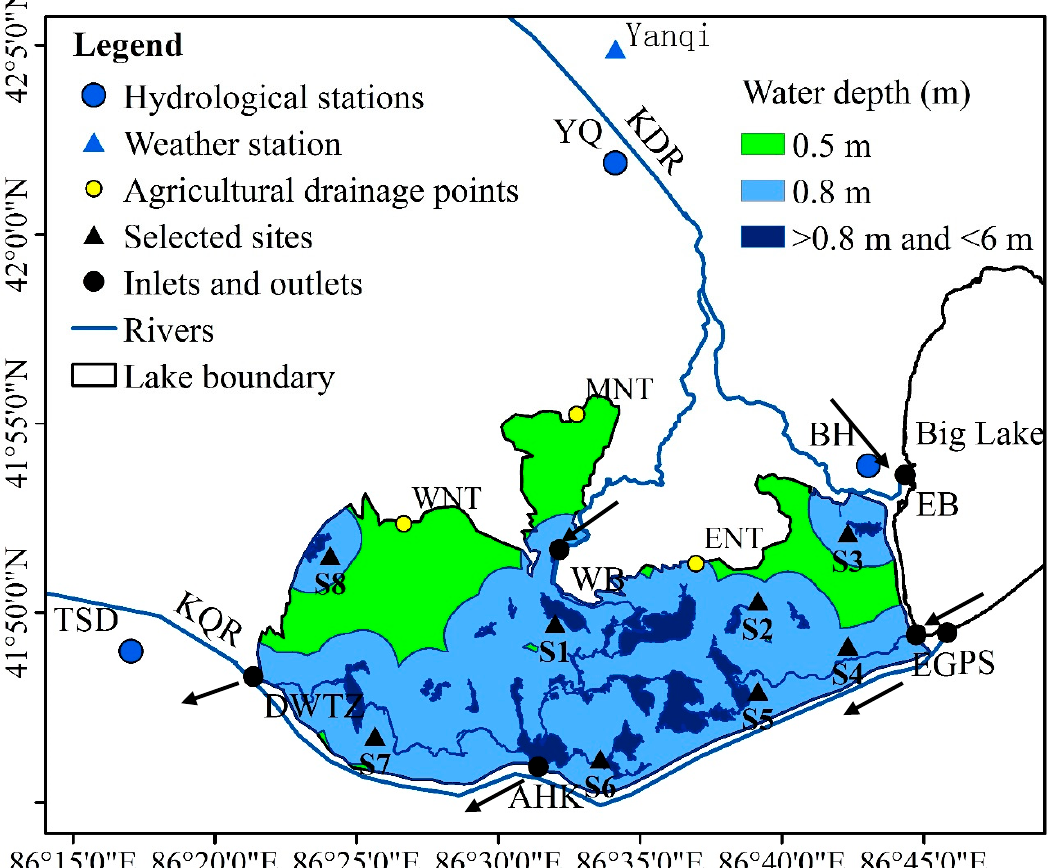
Figure 2. The schematic map of the small lake and its water depth (where black solid triangles show the location of the selected sites for presenting spatial change of water age; KDR, KQR, TSD, YQ, and BH stand for the Kaidu River, the Kongque River, the Tashidian, Yanqi, and Bohu stations, respectively; black sold circles represent the inlets and outlets of the small lake and big lake, in which WB and EB represent the inlets of the west branch and the east branch of Kaidu River and EG, DWTZ, PS, and AHK represent the ecological gate, Dawutizha gate, pumping station, and Ahongkou gate; the yellow solid circles show the agriculture drainage points, in which WNT, MNT, and ENT represent the west, middle, and east agriculture drainage point, respectively; the black arrows show the schematic flow direction of the inlets and outlets; the bathymetry was designed through field investigation data used for the EFDC (Environmental Fluid Dynamics Code) hydrodynamic modeling).